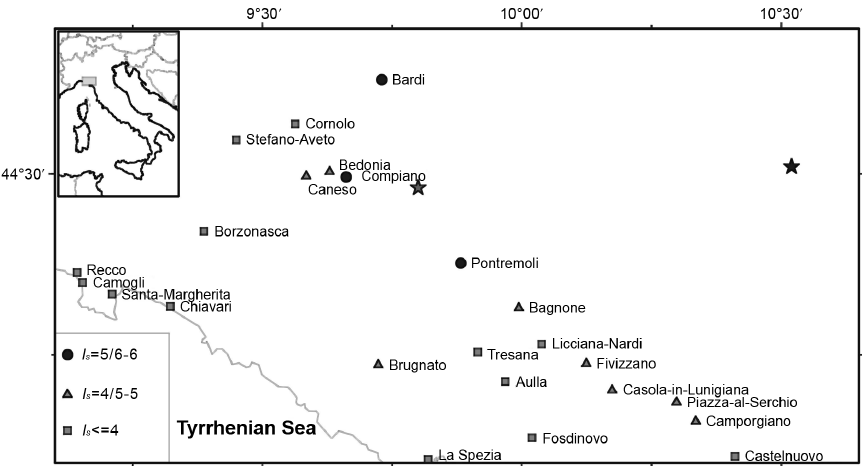
Fig. 5. intensities for the 1934 event (DOM, Monachesi and Stucchi, 1997). The grey star shows the macro- seismic location, the black one marks the instrumental one proposed in this study.